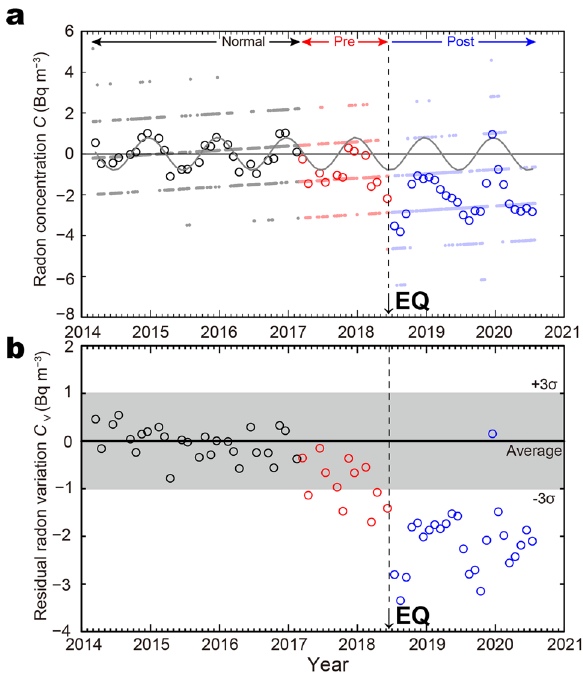
Figure 3. Time series in the atmospheric radon concentration. ( a ) Radon concentration; grey line represents a sinusoidal regression curve (Eq. (1)) that best fits the radon concentration data (open black circles) during the normal period. Black, red, and blue represent data during normal, preseismic, and postseismic periods, respectively. Small dots are raw data. ( b ) Residual radon variation C V ; The area between + 3σ and − 3σ is shown in the grey area in ( b